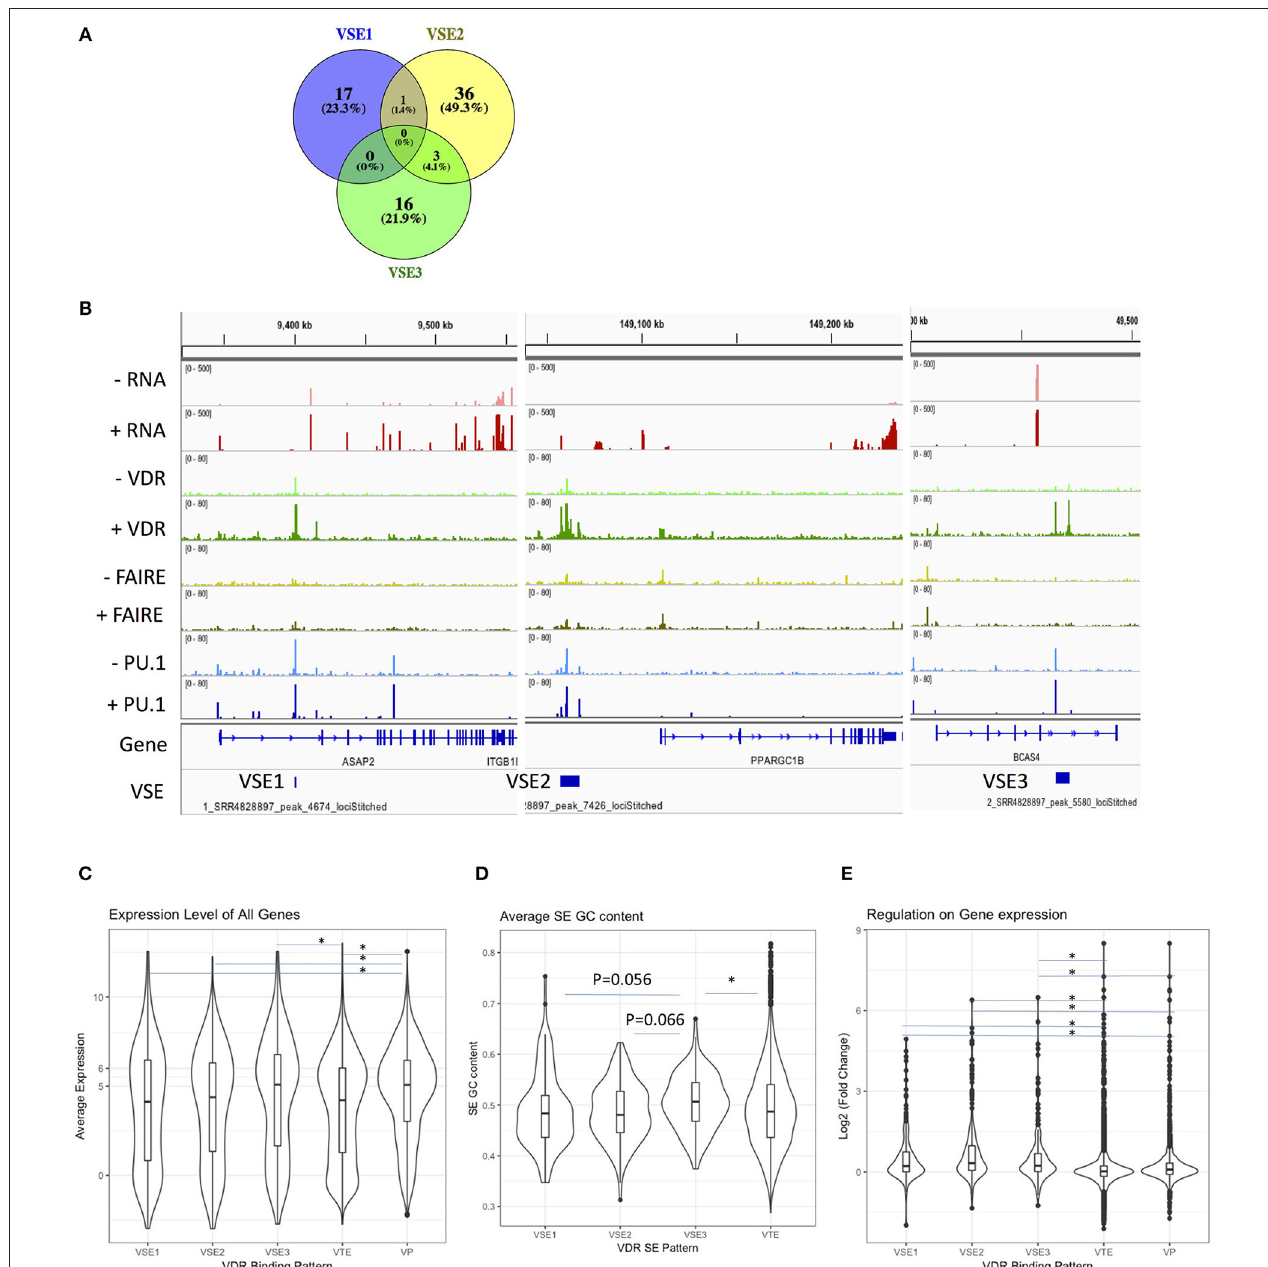
FIGURE 3 | The regulatory effects of VSE1–3 on gene expression. (A) The overlap between VSE1–3 close genes. (B) The visualization of signal density in representative VSE1–3 regions. (C) Average expression level of genes close to different regulatory patterns. (D) The GC content of VSE and VTE. (E) Regulatory effect of different regulatory patterns on gene expressions. VSE, VDR SE; VTE, VDR typical enhancer; VP, VDR promoter binding. To analyse statistical significance, we used a Kruskal–Wallis test followed by Bonferroni correction * p <